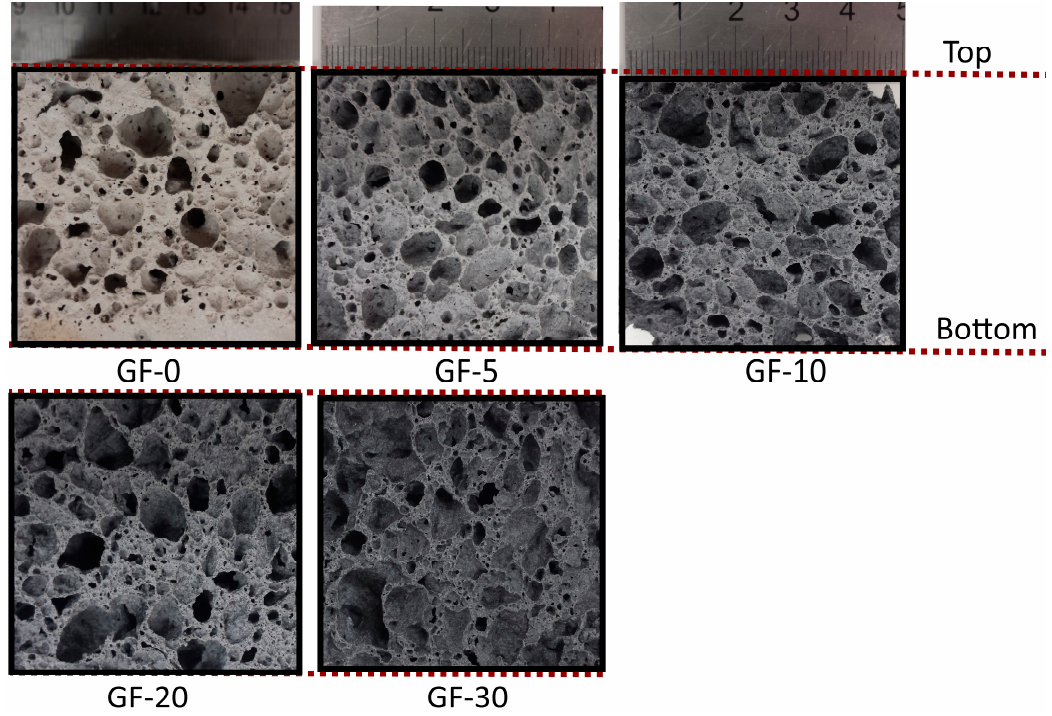
Figure 6. The images of the foam samples containing different coke dust contents.